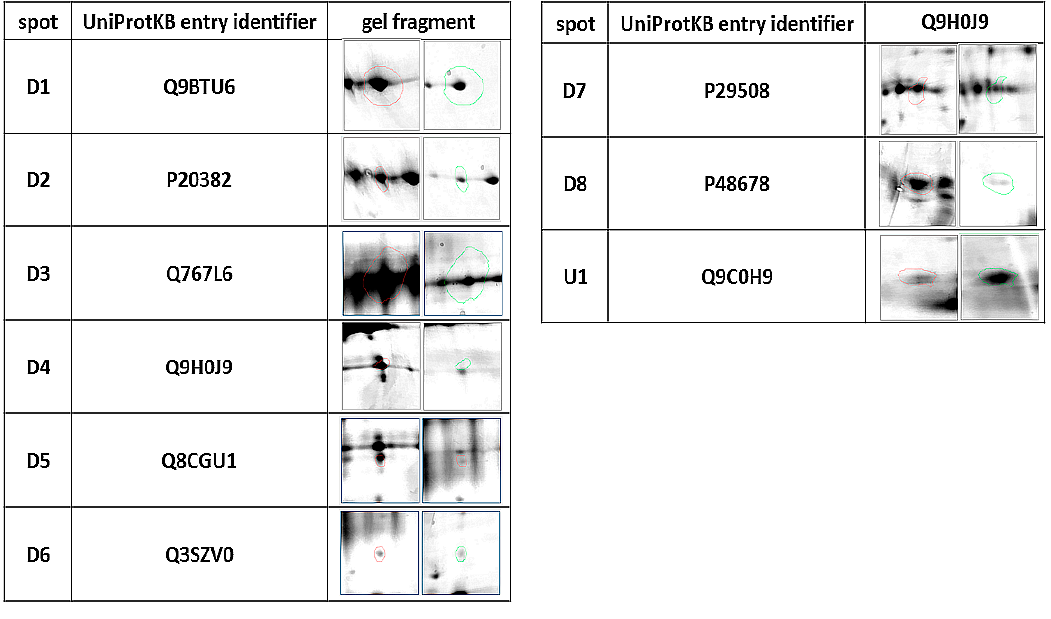
Figure 1. Statistically significant ( p ≤ 0.05) representatives of 2DE gel spots in the diabetic group compared to control group as revealed by the Delta2D software. The column of spots on the left side are from the control group, and on the right are from the diabetic group.